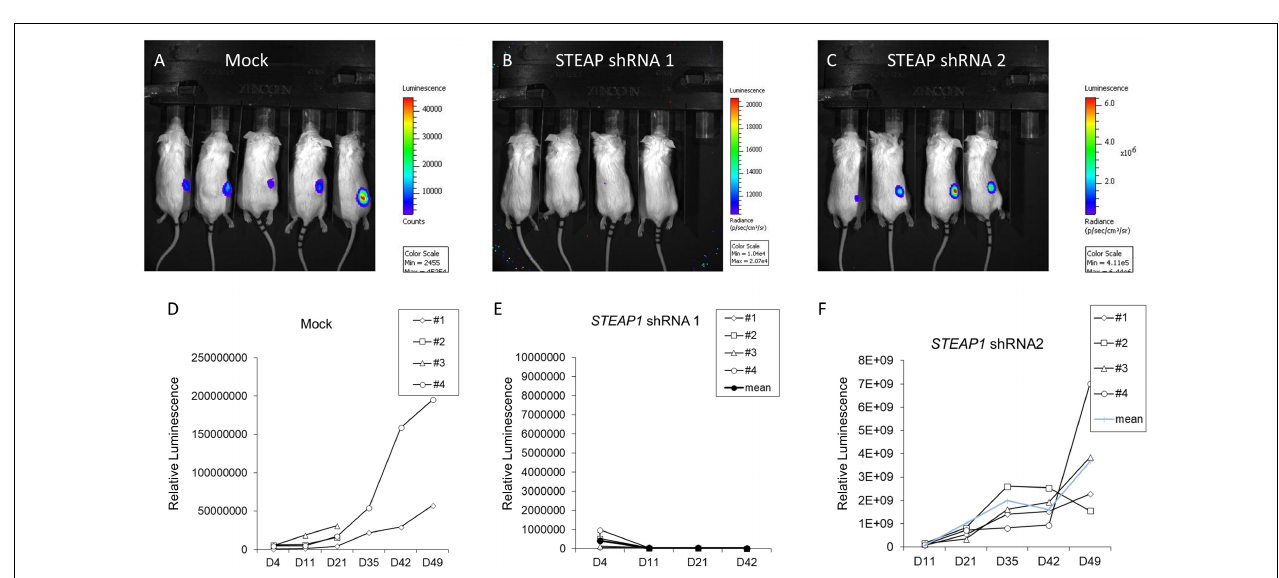
FIGURE 2 | STEAP potentiates cell growth and in vitro metastatic properties in gastric cancer. (A) STEAP1 mRNA expression was significantly downregulated in MKN45 cells transfected with siRNA targeting STEAP1 . Relative mRNA expression of STEAP1 , normalized to GAPDH expression, in mock and siRNA- STEAP1 are shown. Data represents mean ± standard deviation of three independent replicates. MTT assay-based determination of cell proliferation (B) , in vitro migration (C) , and in vitro invasion (D) in mock transfected MKN45 cells and MKN45 cells transduced with siRNA targeting STEAP1 . In each case, data shown are mean ± standard deviation of three independent replicates. ∗ p <